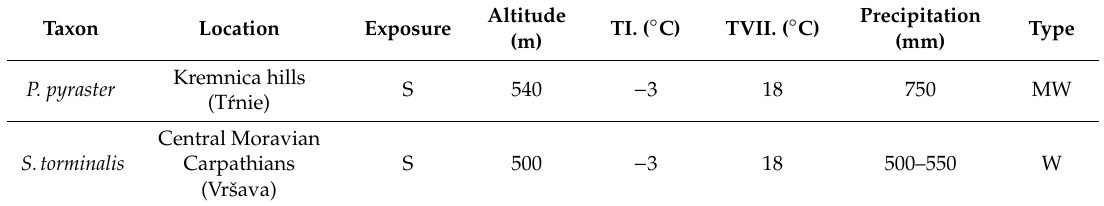
Table 1. Climatic-geographic description of the original stands of woody plants [34].